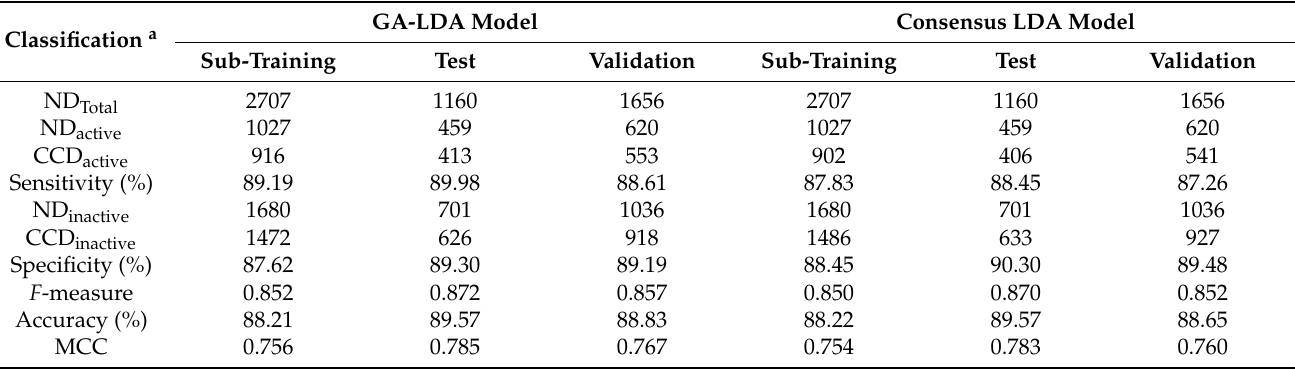
Table 3. Predictive ability by different LDA